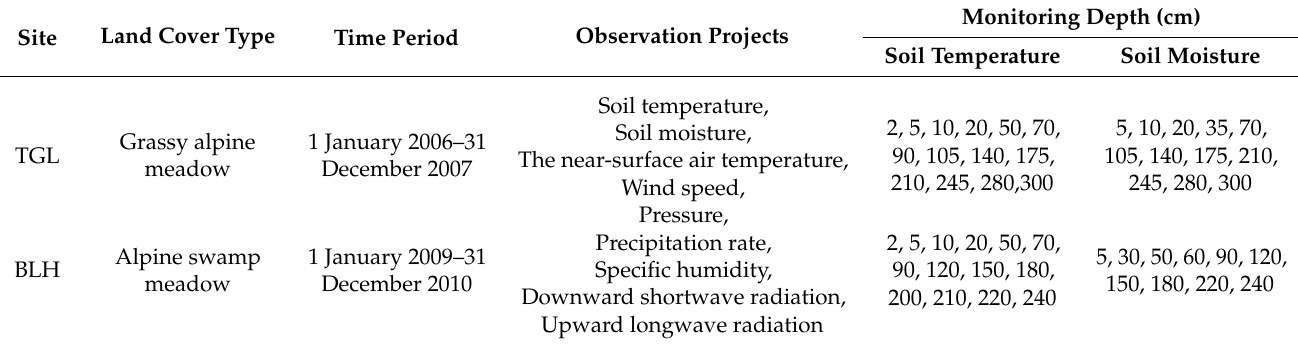
Table 1. Information on the observed